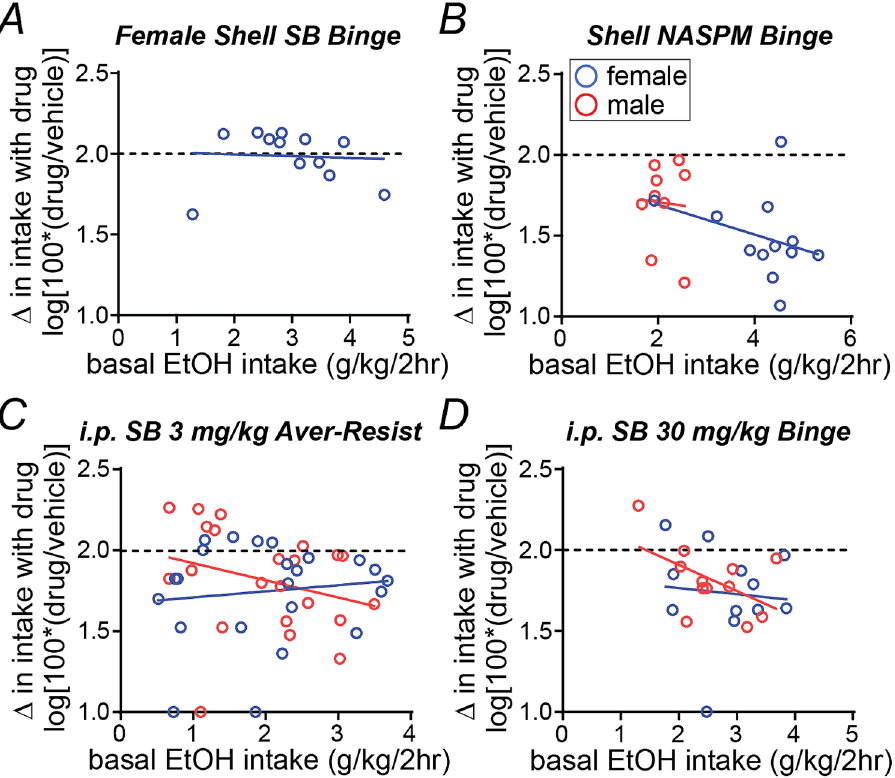
Figure 5. The impact of Ox1R or CP-AMPAR inhibition was minimally related to basal alcohol intake levels across individual mice. For theses analyses, basal intake in each mouse was determined from vehicle injection days, and the change in drinking with drug was determined by log transforming the percent change in drinking (see “Material and methods”). ( A – D ) Basal intake was not correlated with change in drinking after ( A ) shell SB infusion in females, ( B ) shell NASPM infusion in either sex, ( C ) systemic 3 mg/kg SB in either sex (quinine- resistant intake), or ( D ) systemic 30 mg/kg SB infusion in either